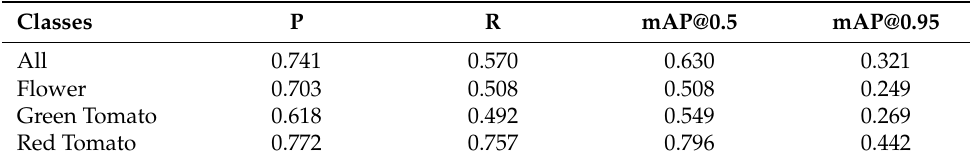
Table 2. Best mAP@0.5 and mAP@0.95 performance parameters